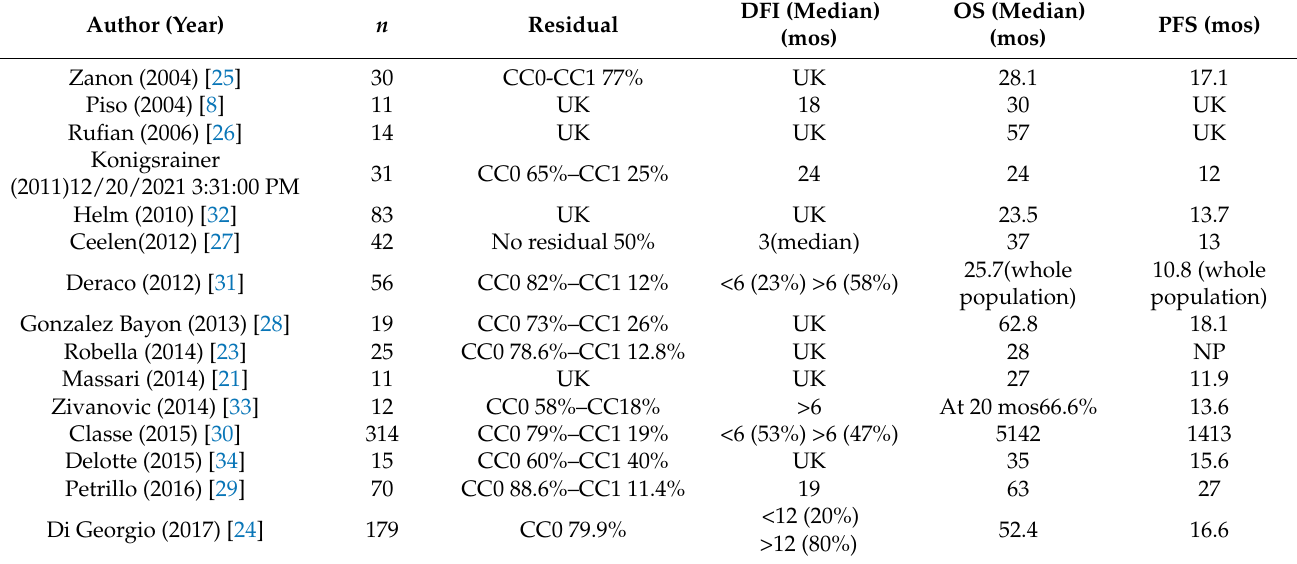
Table 2. Series of cytoreductive surgery and hyperthermic intraperitoneal chemotherapy (HIPEC) for ovarian cancer first relapse with no control group: residual tumors and survival results. ( PIC O: Outcomes OS and